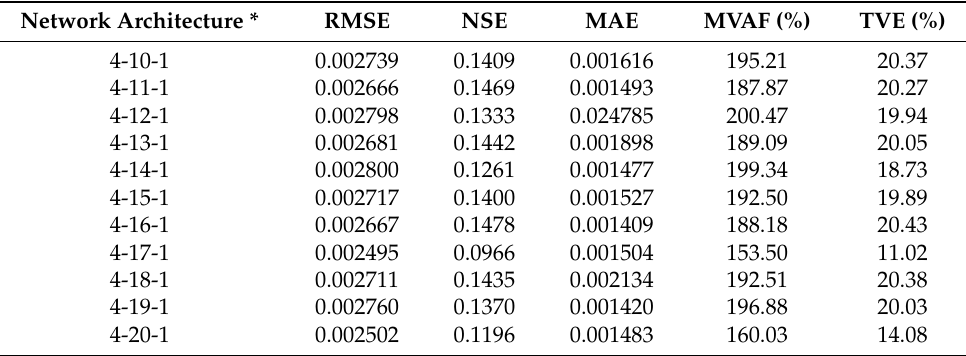
Table 1. Results of the RBFNN model with different network architectures.